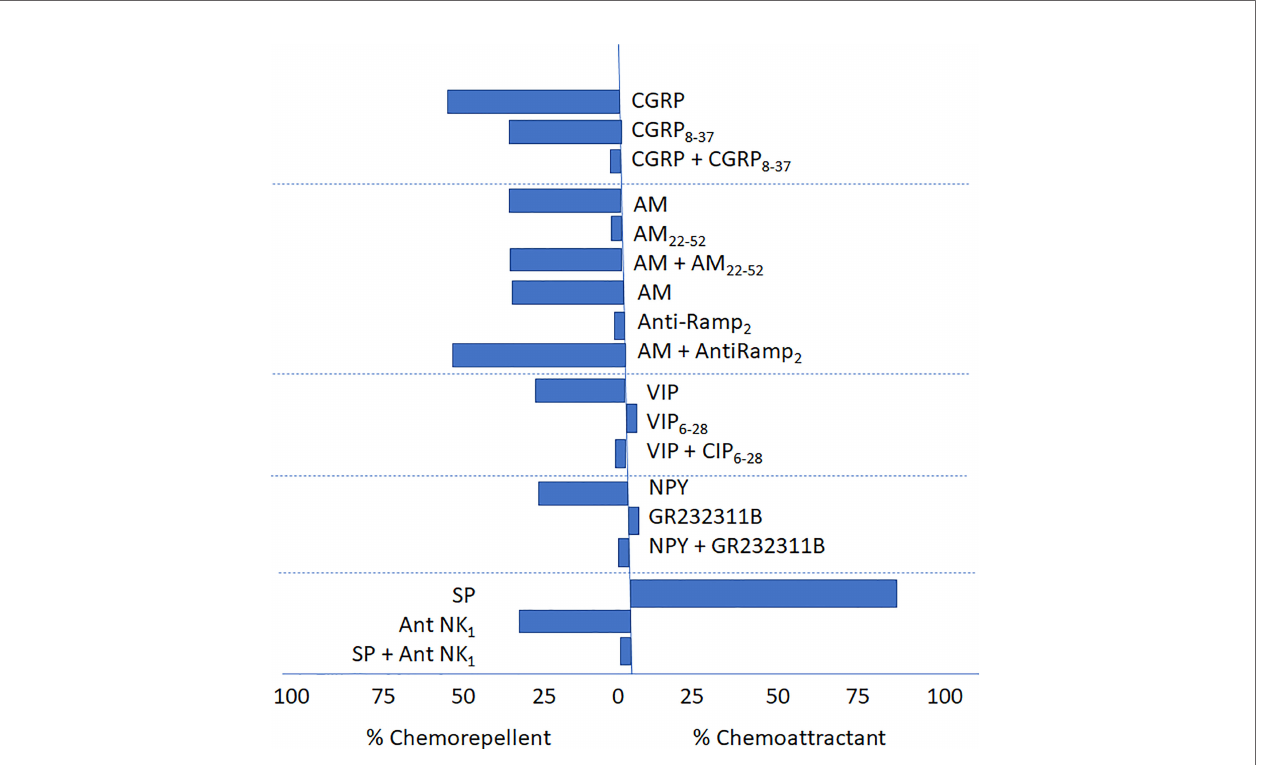
FIGURE 3 | Antagonism of CGRP8 – 37, AM22 – 52, Anti-RAMP-2, VIP (VIP6-28), NPY (GR2323118) and (D-Pro2, D-Trp7,9]-Substance P, on the chemotactic response elicited by CGRP, AM, VIP, NPY and SP, on L. (V.) braziliensis . (Febres et al., 2018, Giammarressi et al., 2020; Febres et al., 2021). The fi gure details the chemoattractant or chemorepellent effect (as percentages, see the abscisa) of sensorial and autonomic peptides and their respective antagonist (either alone or in combination with the agonist) and their effect on the migratory response in Leishmania ( V .) braziliensis. In the case of AM a speci fi c antibody, Anti-RAMP-2 was also